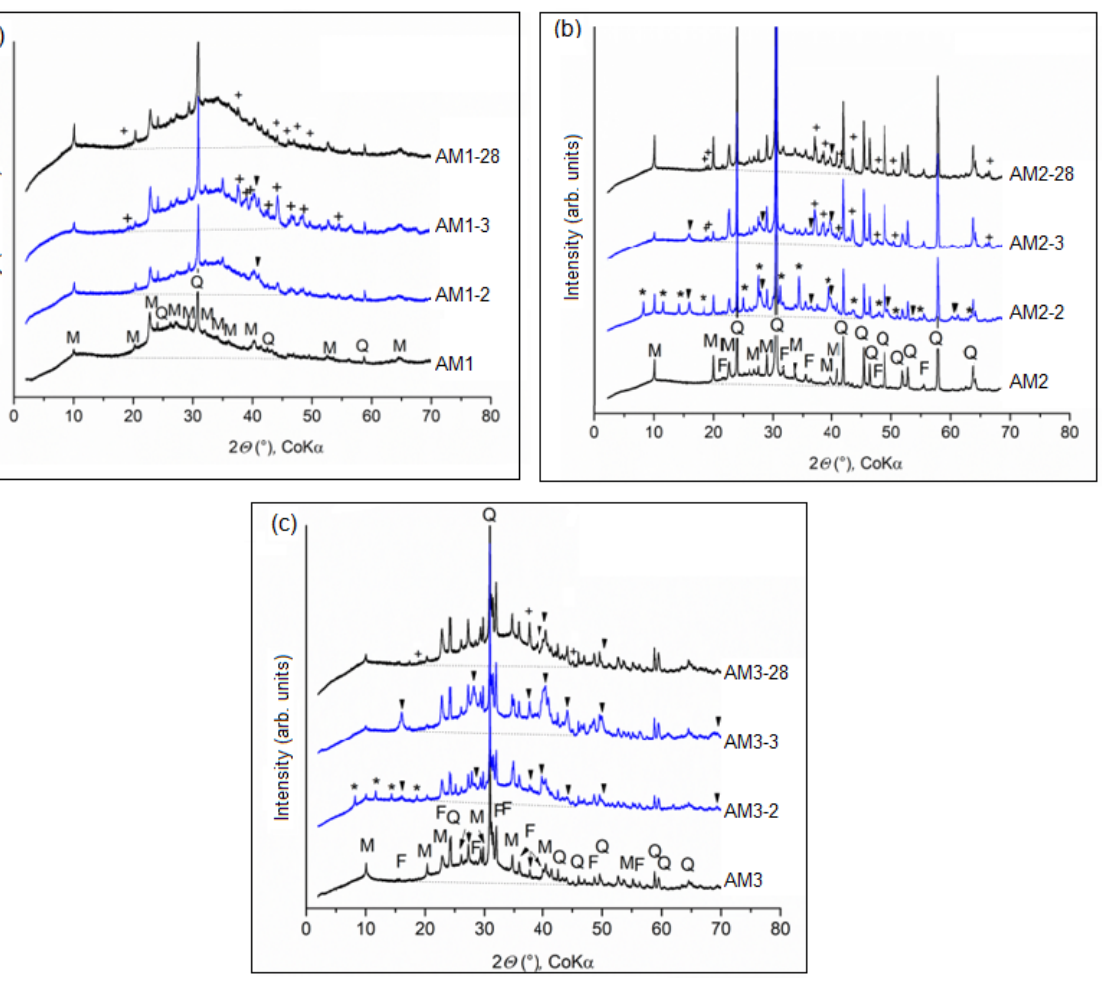
Figure 3. XRD patterns of alkali-activated metakaolins: ( a ) M1, ( b ) M2 and ( c ) M3. Q—quartz, M— muscovite, F—orthoclase, *—zeolite A, ꞌ —hydrosodalite, +—thermonatrite. The area of halo under the amorphous scattering hump is separated from the background by a dotted line.